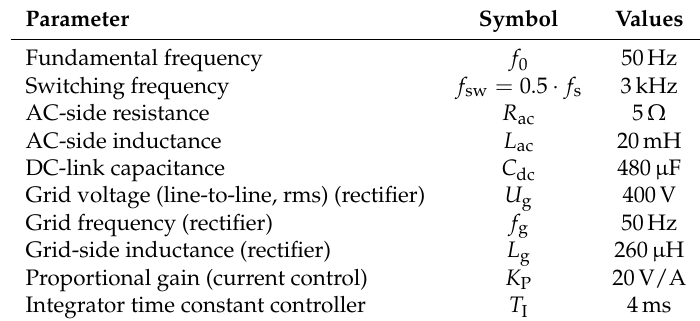
Table 1. Parameters of the example system.